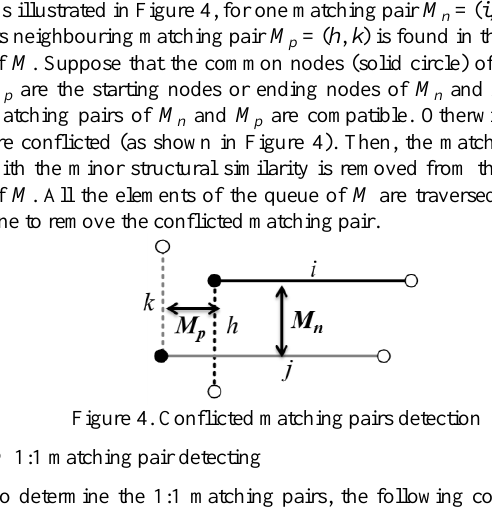
checked by the step of Matching pair confliction filtering . The remain elements of the queue of M and the detected 1: 1 matching pairs will be selected as the final matching